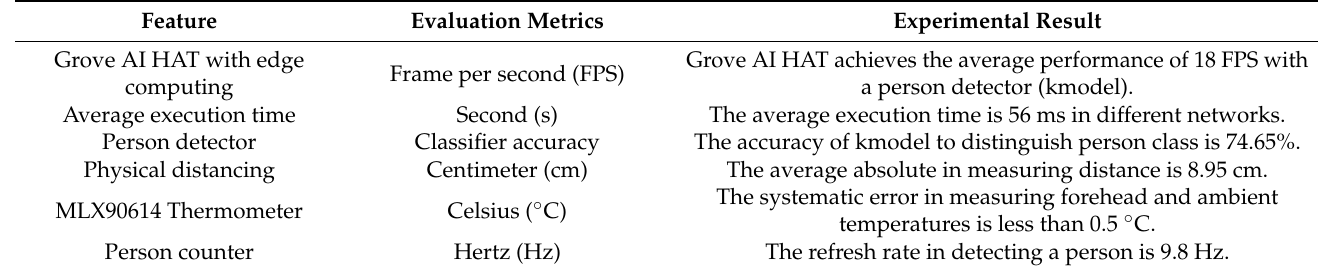
Table 10. Summary of the performance of various devices in PADDIE-C19.